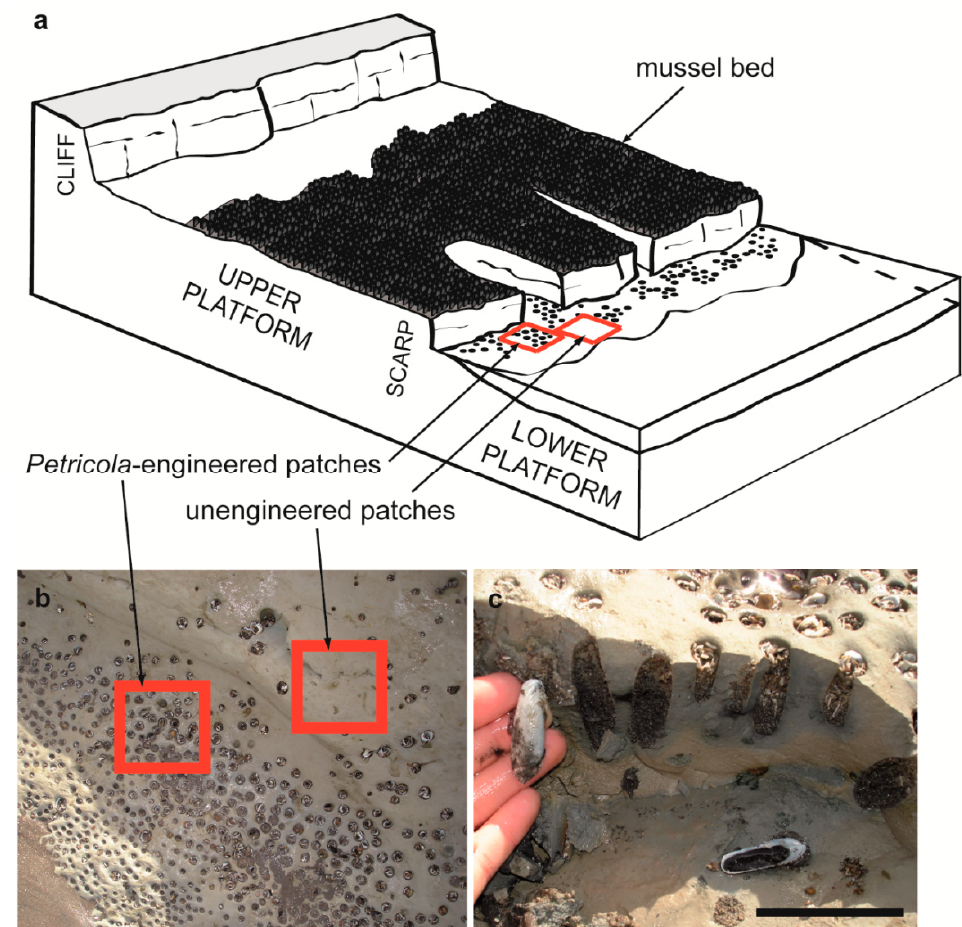
Figure 1. ( a ) Scheme of the horizontal shore platform at El Espigón, showing upper and lower platforms separated by a scarp. Arrows show the position of the mussel beds, Petricola -engineered patches (with boreholes) and unengineered patches (without burrows). ( b ) Close view of Petricola -engineered and unengineered patches. The red squares are scaled, 10 cm side quadrats as those used for sampling. ( c ) Lateral view of boreholes filled with sediment and empty Petricola dactylus shells (the rock was cut perpendicular to the surface). Scale is 5 cm.